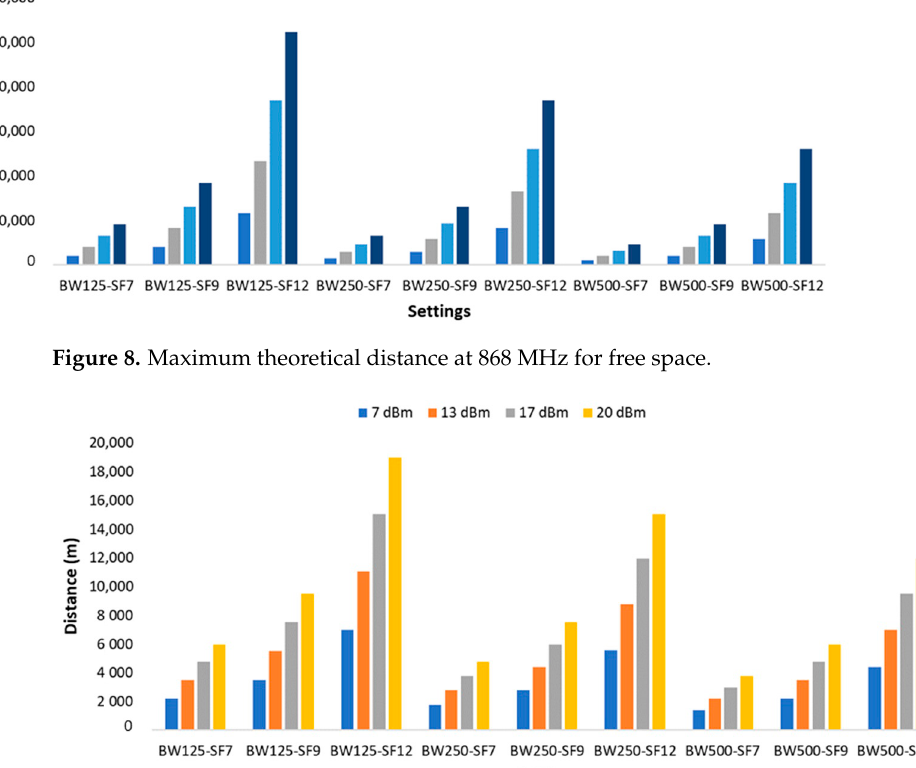
Figure 9. Maximum theoretical distance at 868 MHz for few obstacles.